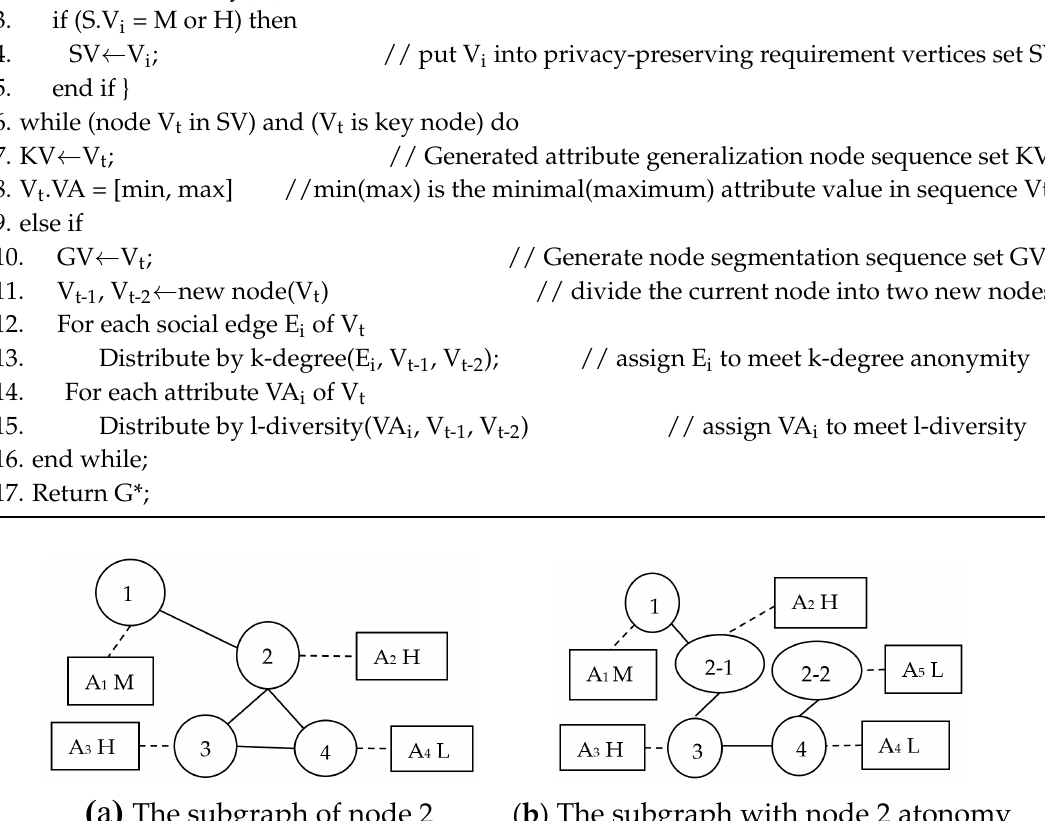
Figure 3. An example of DKDLD-UL: An anonymous graph with node segmentation. ( a ) The subgraph of node 2; ( b ) the subgraph with node 2 atonomy.